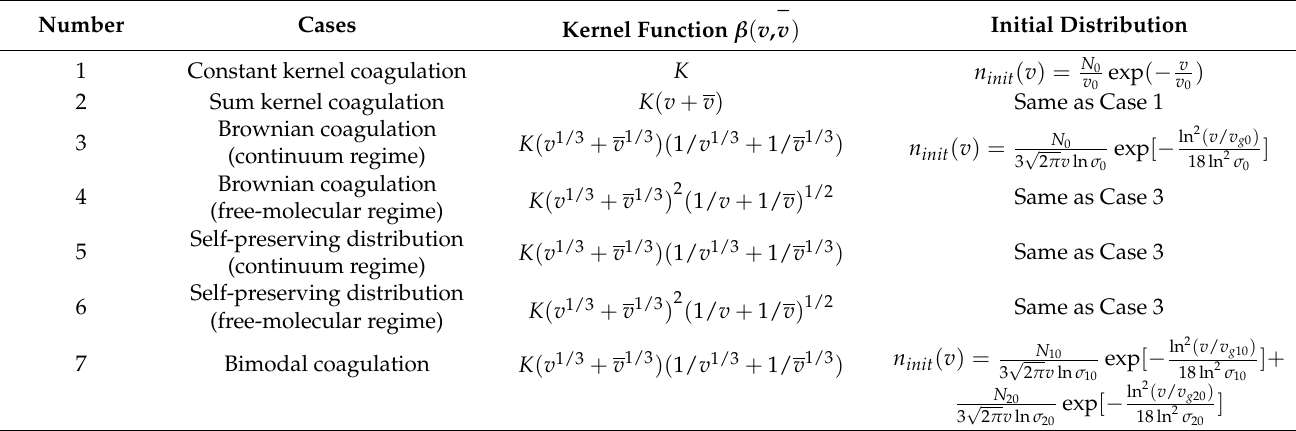
Table 1. Numerical cases for the validation of the RBF